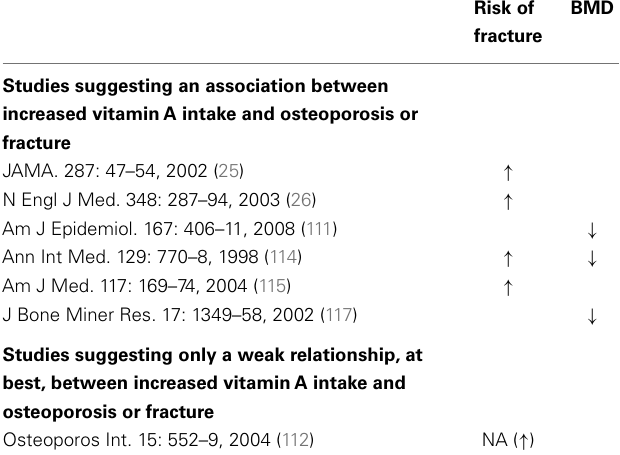
Risk of fracture